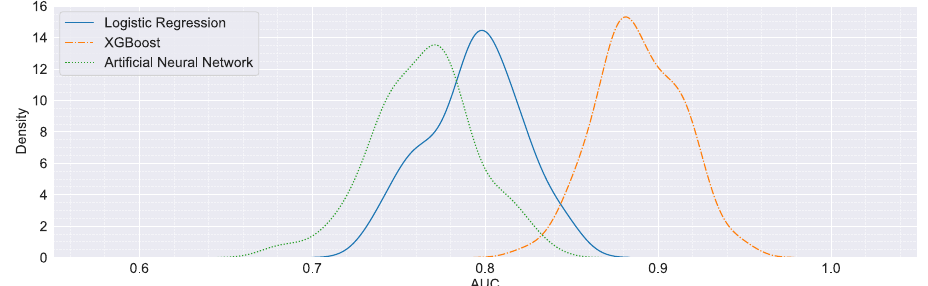
Figure 11. AUC (Area Under Curve) of Machine Learning